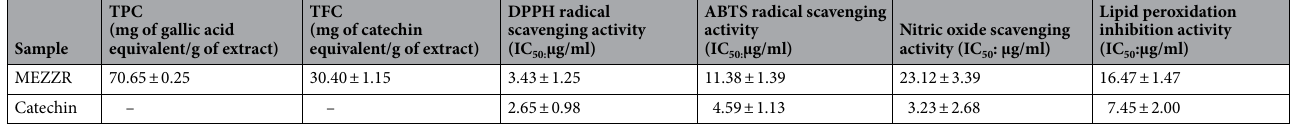
Table 2. Phytochemical analysis and antioxidant effect of MEZZR. Data are expressed as mean ± SD. TPC Total phenolic content, TFC Total flavonoid content, Catechin used as a standard.